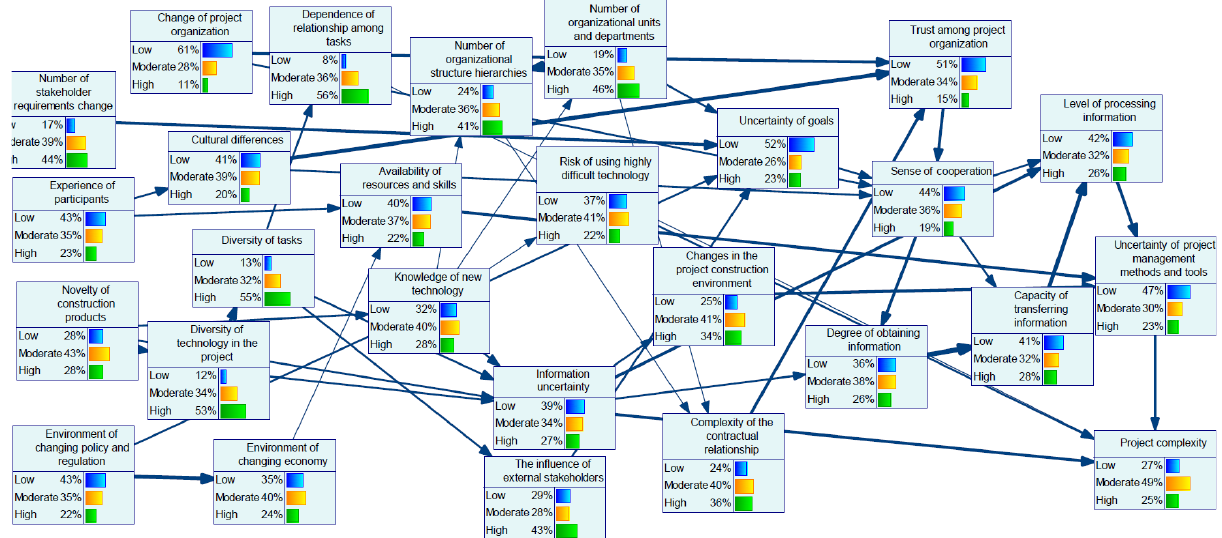
Figure 9. Results of influence chain analysis of BBN-based project complexity measurement